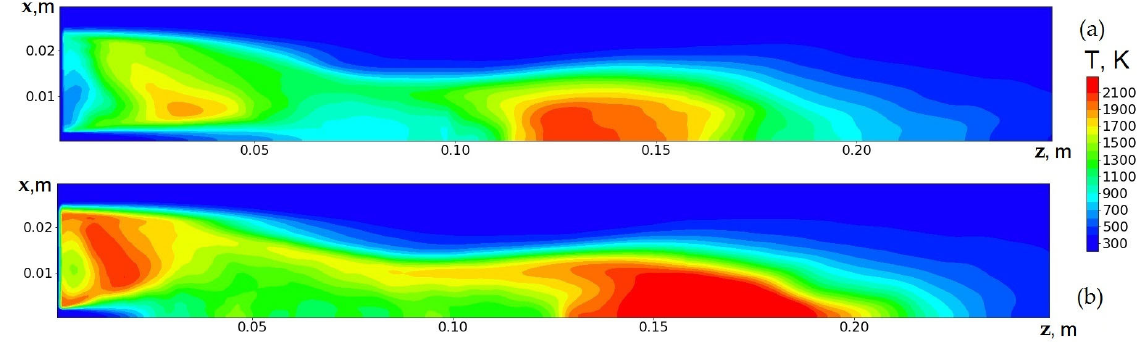
Figure 9. Time- and angle-averaged temperature field, ( a ) Smagorinsky model, and ( b ) DSM.